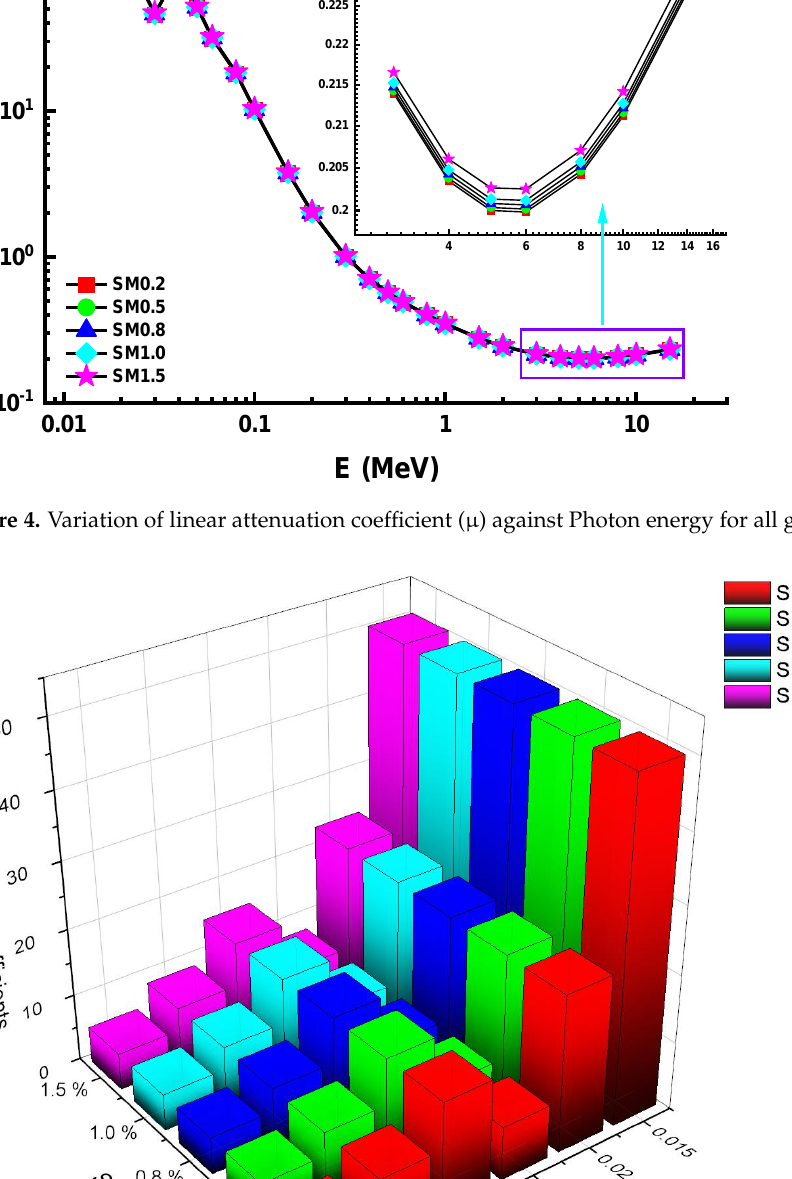
Figure 5. Variation of mass attenuation coefficients (µ m ) at low energy region.